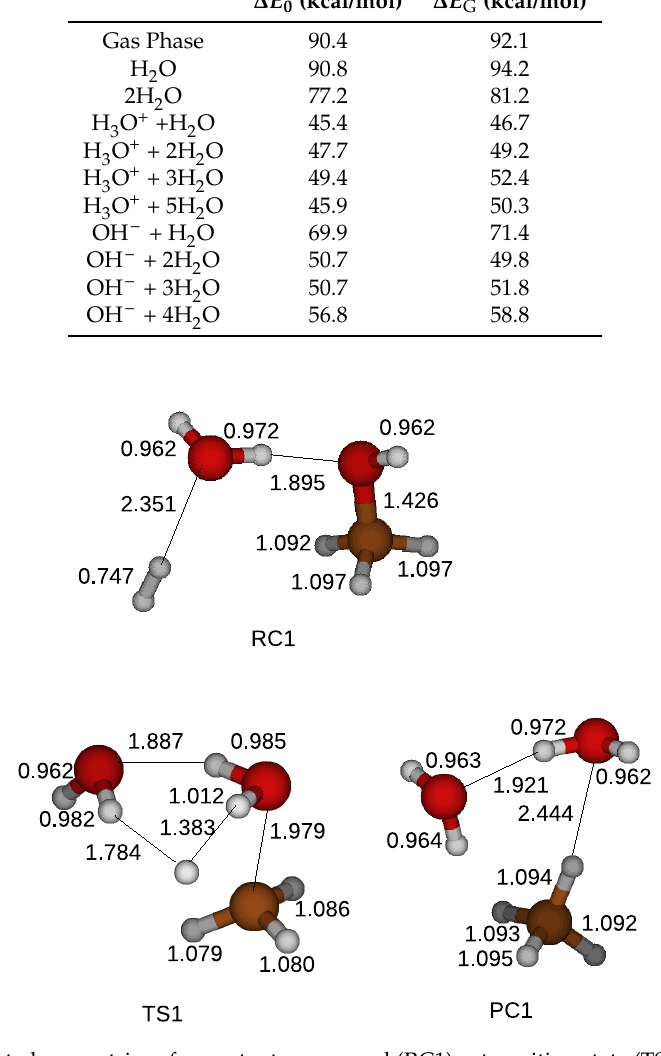
Figure 3. Calculated geometries of a reactant compound (RC1), a transition state (TS1), and a product compound (PC1) for the reduction of a methanol when a water molecule is introduced in the